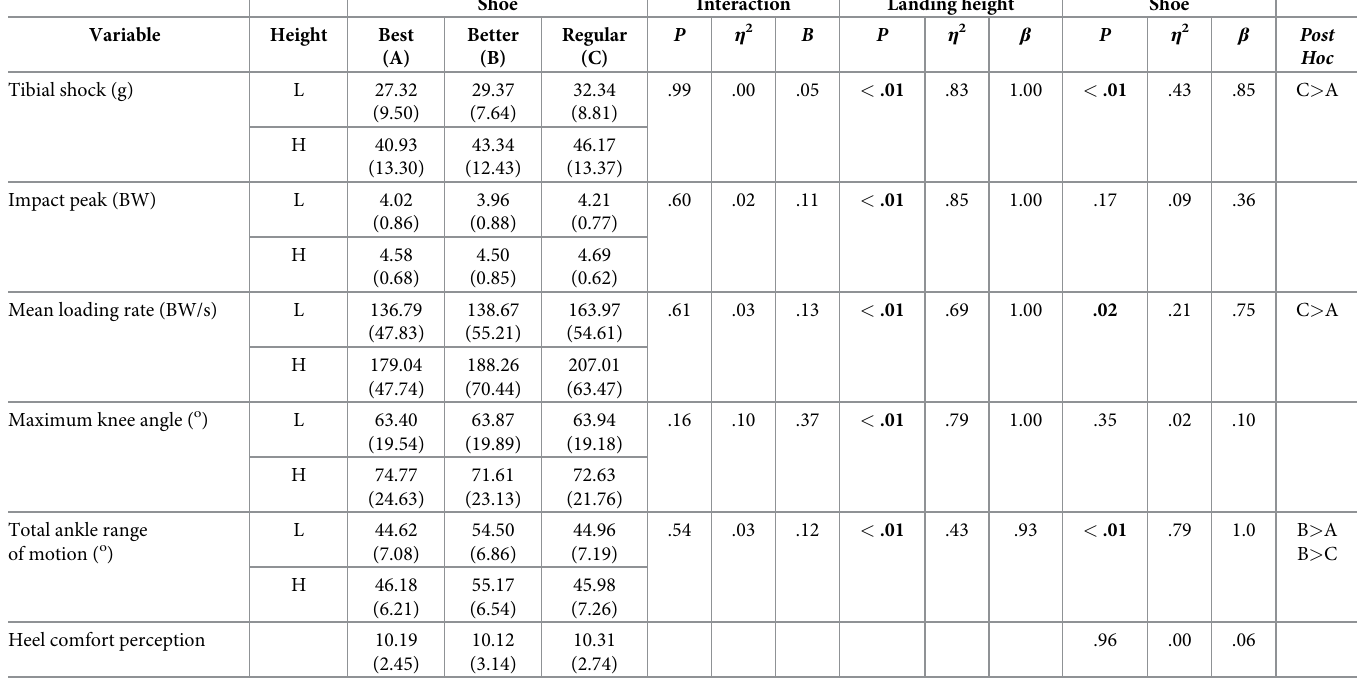
Table 1. Landing kinematic, GRF and tibial acceleration variables during each landing height expressed in mean (standard deviation). n 2 = partial eta squared; β = observed power (Table A in S1 File). Shoe Interaction Landing height Shoe Variable